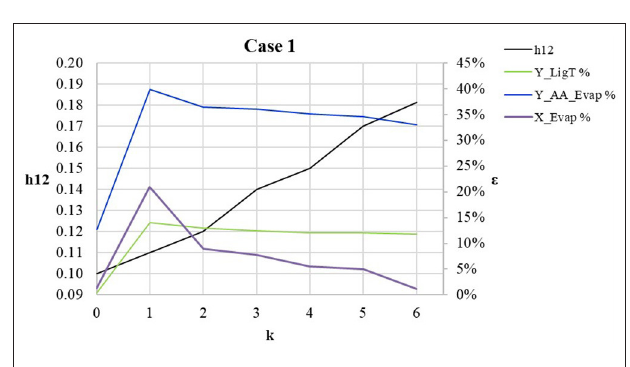
FIGURE 4 | Error vs. iteration—case 1.